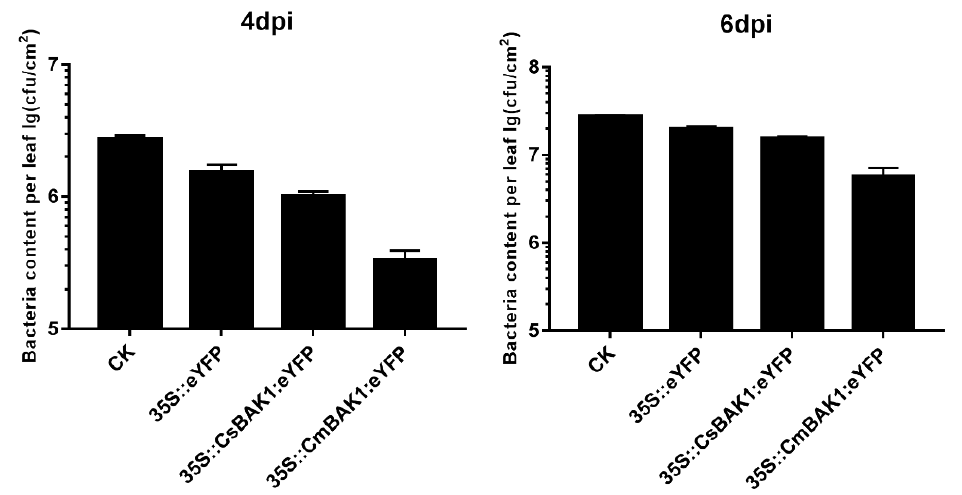
Figure 6. Xcc growth in each leaf after transient overexpression of BAK1. CK: control injected with buffer solution. 35S::eYFP : control injected with Agrobacterium of empty vector. 35S::CsBAK1::eYFP : leaves injected with Agrobacterium of empty vector 35S::CsBAK1::eYFP. 35S::CmBAK1 ::eYFP leaves injected with Agrobacterium of empty vector 35S::CmBAK1::eYFP.